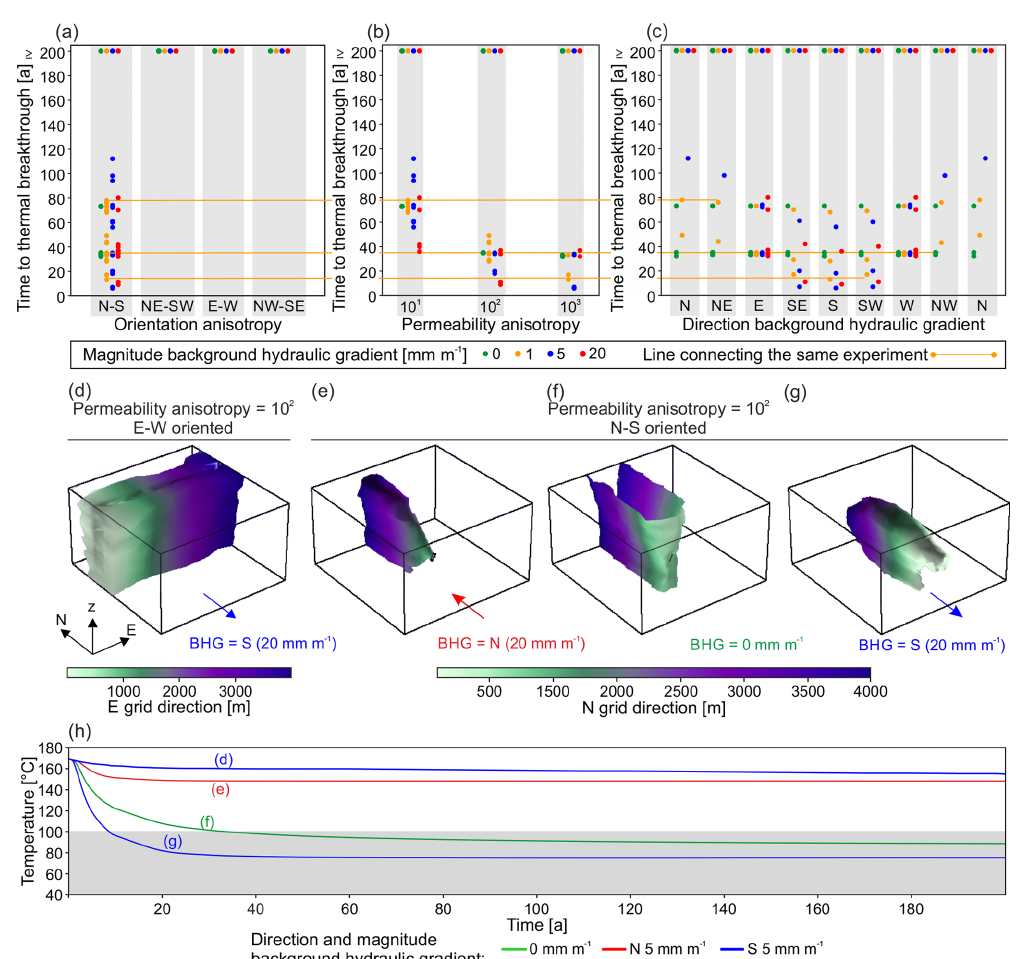
Figure 5. Parameter values against time to thermal breakthrough for model experiments with vertically oriented fracture anisotropy (Scenario 3). Panels (a) , (b) , and (c) each contain the same results of 300 simulations but are arranged according different x axes. The results show that permeability anisotropy largely controls time to thermal breakthrough and that the effect of anisotropy reaches its maximum at 10 2 . (a) For cases with the anisotropy (sub)parallel to well configuration the BHGs direction is of importance and causes either a very short or long reservoir lifetime. (d) , (e) , (f) , and (g) HDI after 100 years. The HDI forms a vertical volume parallel to the orientation of the anisotropy, independent of the direction of the BHG. Panel (h) shows the development of the production temperature over time for the models presented in (d) – (g)